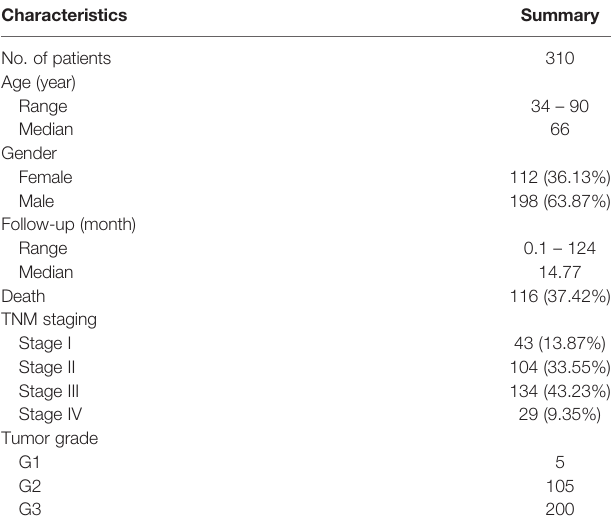
TABLE 1 | Patient demographic and clinical characteristics.